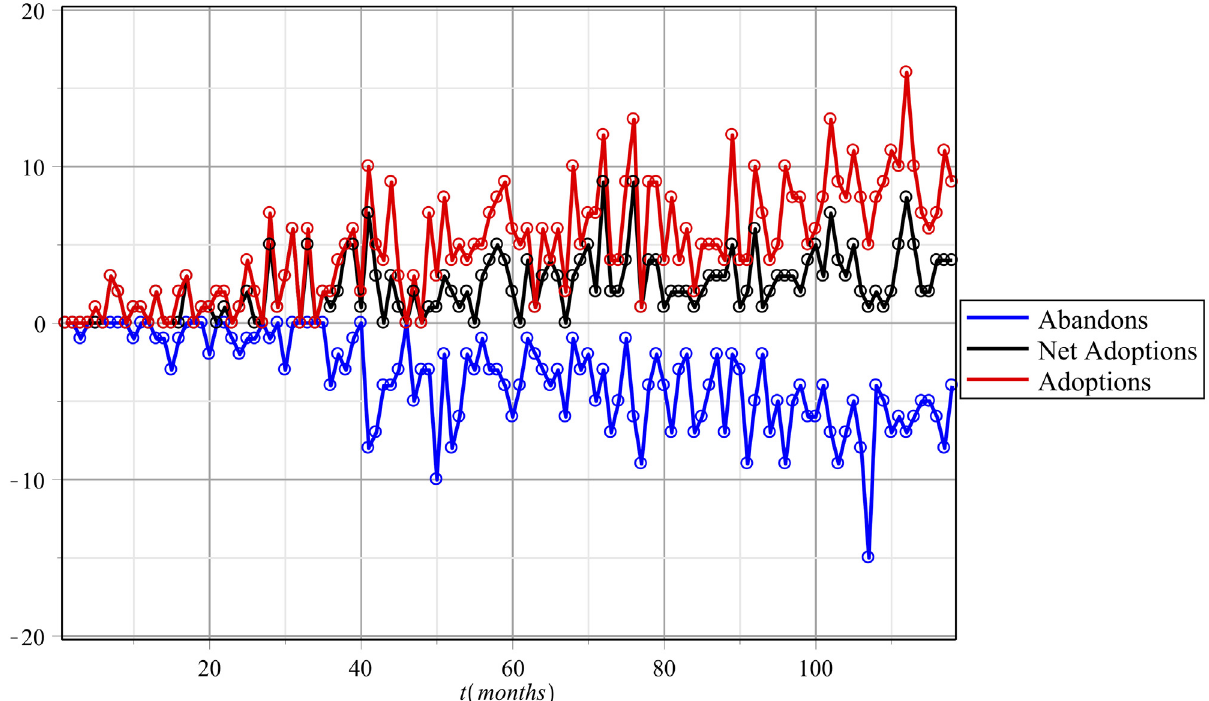
Fig 2. Fluctuations per month. The red line indicates the number of people who transitioned from susceptible to infected (0 ! 1); the blue line reveals the number who transitioned from infected to susceptible (1 ! 0); and black shows the net change in the total number of adoptions for the given